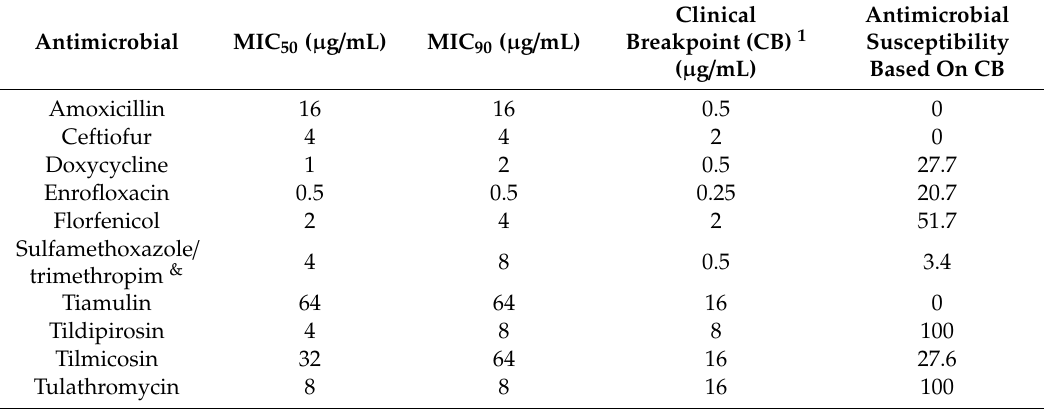
Table 1. Bordetella bronchiseptica (BB), MIC 50 , MIC 90 , current recommended clinical breakpoints (CB) and antimicrobial susceptibility. The MIC 50 and MIC 90 were determined from the MIC distribution from 29 BB strains isolated from respiratory clinical cases. The antimicrobial susceptibility was calculated as the percentage of bacterial isolates below CB.